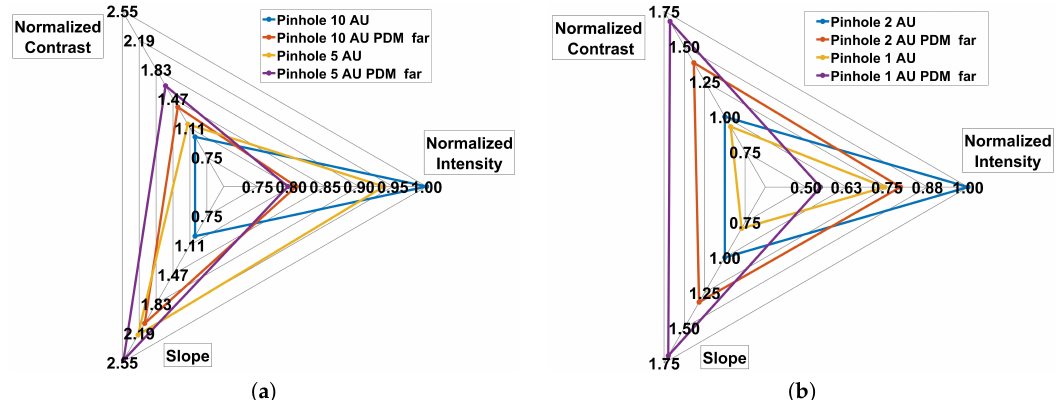
Figure 13. Comparison of the image characteristics of the test chart. ( a ) For the 10 AU pinhole in-focus, with PDM far and 5 AU pinhole in-focus and with PDM far . ( b ) For the 2 AU pinhole in-focus, with PDM far and 1 AU pinhole in-focus and with PDM far